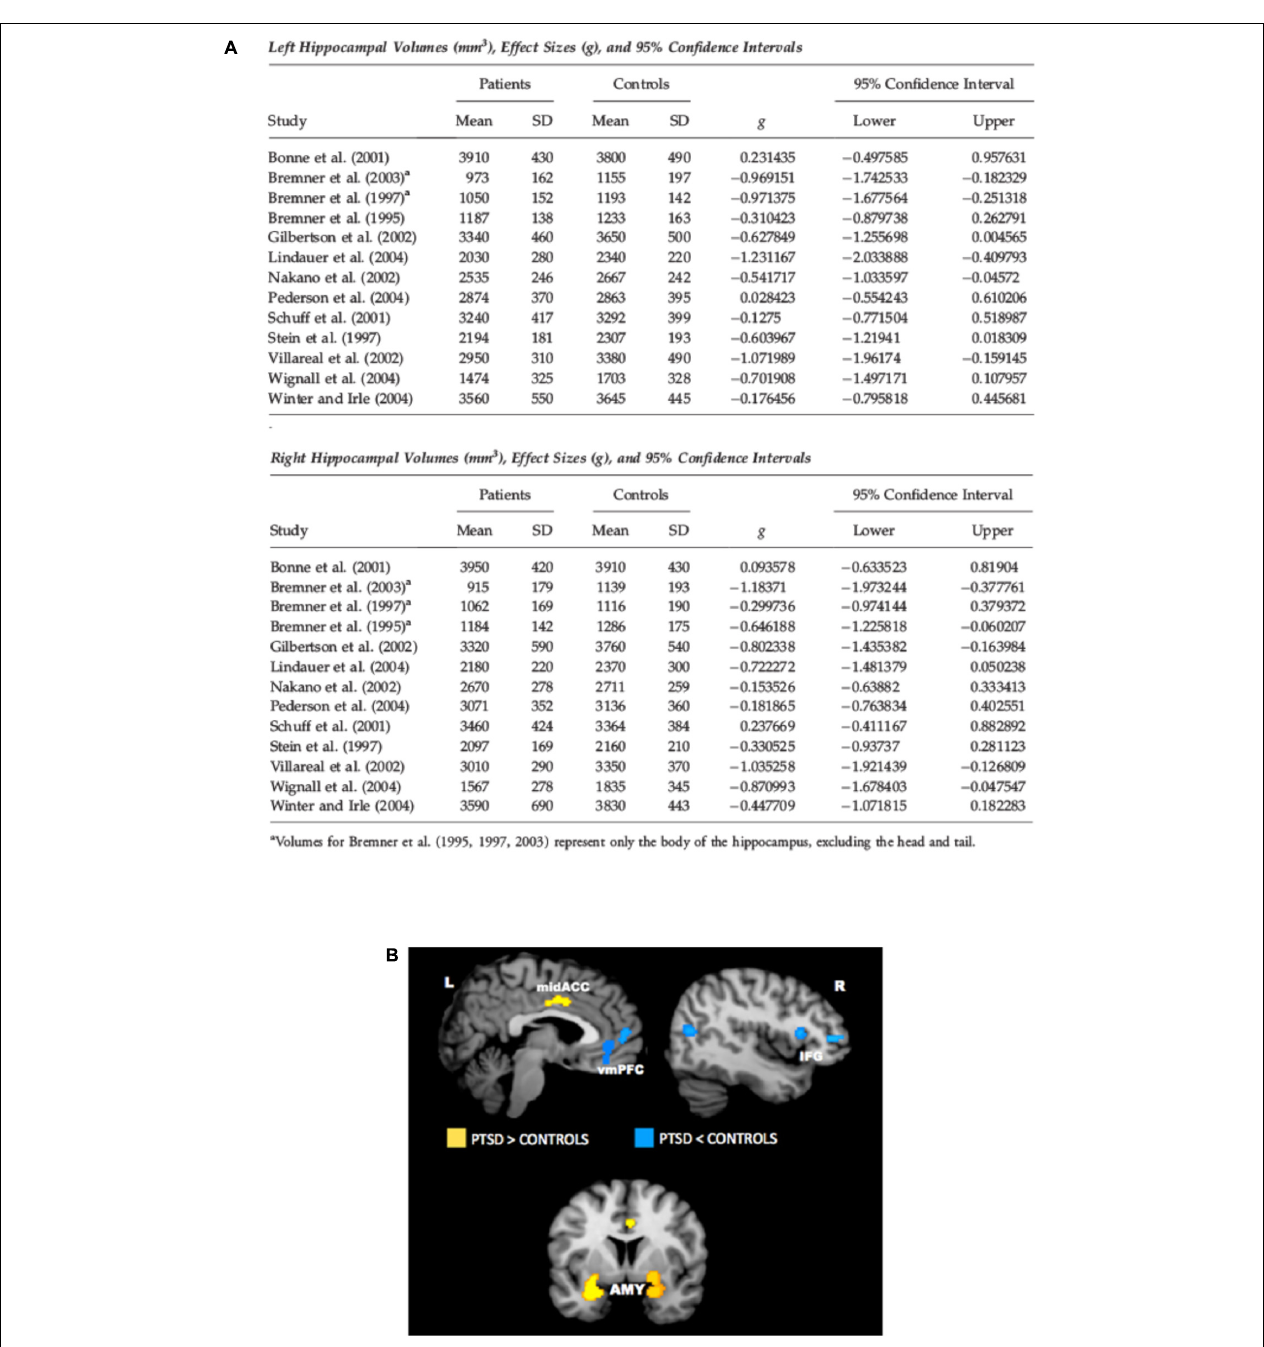
FIGURE 1 | (A) Meta-analysis of studies in which hippocampal volume was estimated from magnetic resonance images in adult patients with PTSD. The meta-analysis included 13 studies of adult patients with PTSD that compared the patients to well-matched control groups (total 215 patients and 325 control subjects). Pooled effect size calculations across the studies indicated significant volume differences in both hemispheres. On average PTSD patients had a 6.9% smaller left hippocampal volume and a 6.6% smaller right hippocampal volume compared with control subjects. These volume differences were smaller when comparing PTSD patients with control subjects exposed to similar levels of trauma, and larger when comparing PTSD patients to control subjects without significant trauma exposure. Reproduced with permission from Smith (2005). (B) Meta-analysis of functional neuroimaging studies in PTSD. Across symptom provocation and cognitive-emotional tasks, the amygdala and mid-ACC are hyperactive in PTSD whereas the lateral and medial prefrontal cortex are hypoactive for negative emotional stimuli vs. neutral and positive stimuli. Areas of hyperactivation in PTSD (PTSD > Control) are shown in yellow, areas of hypoactivation in PTSD (Control > PTSD) are shown in blue. AMY, amygdala; IFG, inferior frontal gyrus; L, left; mid-ACC, mid anterior cingulate cortex; R, right; vmPFC, ventromedial prefrontal cortex. Reproduced with permission from Hayes et al. (2012a).